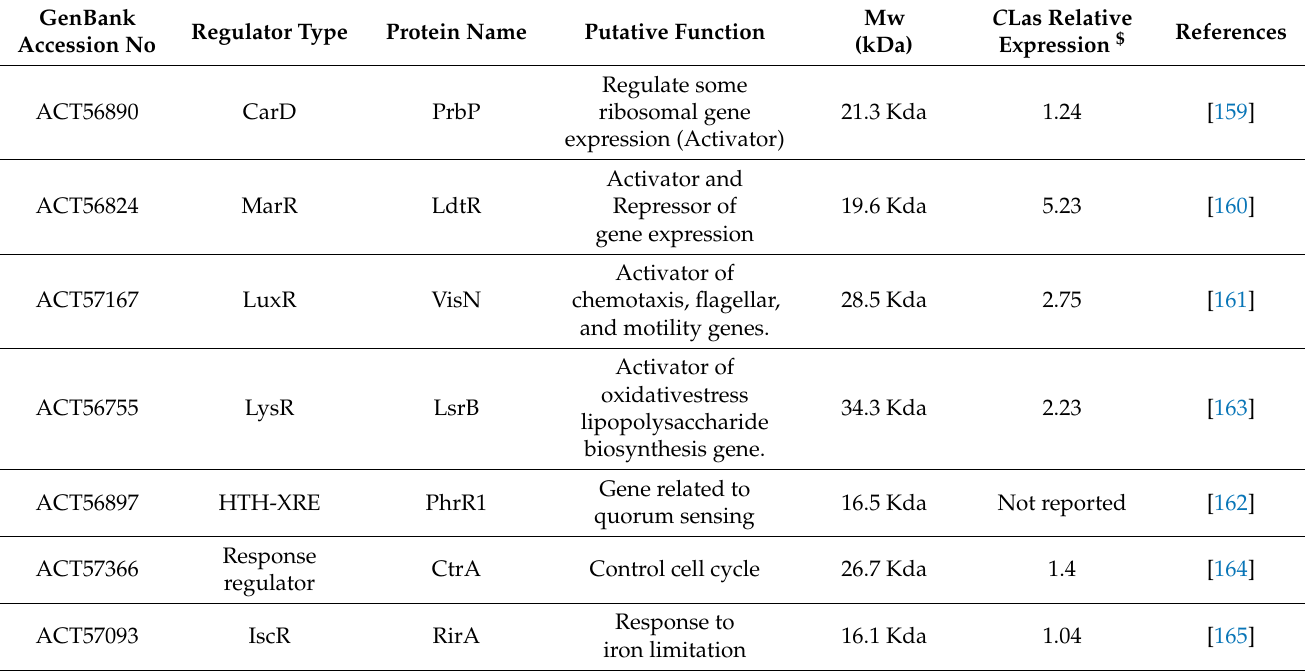
Table 5. Transcription regulators of C